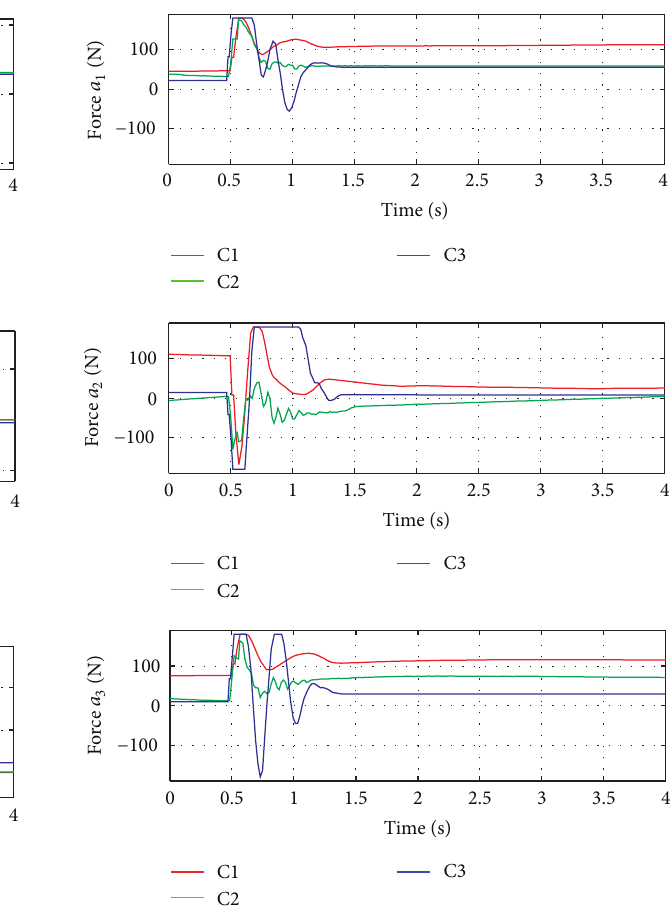
Figure16:Comparativebehaviorofthethreecontrollers:task-space trajectories.